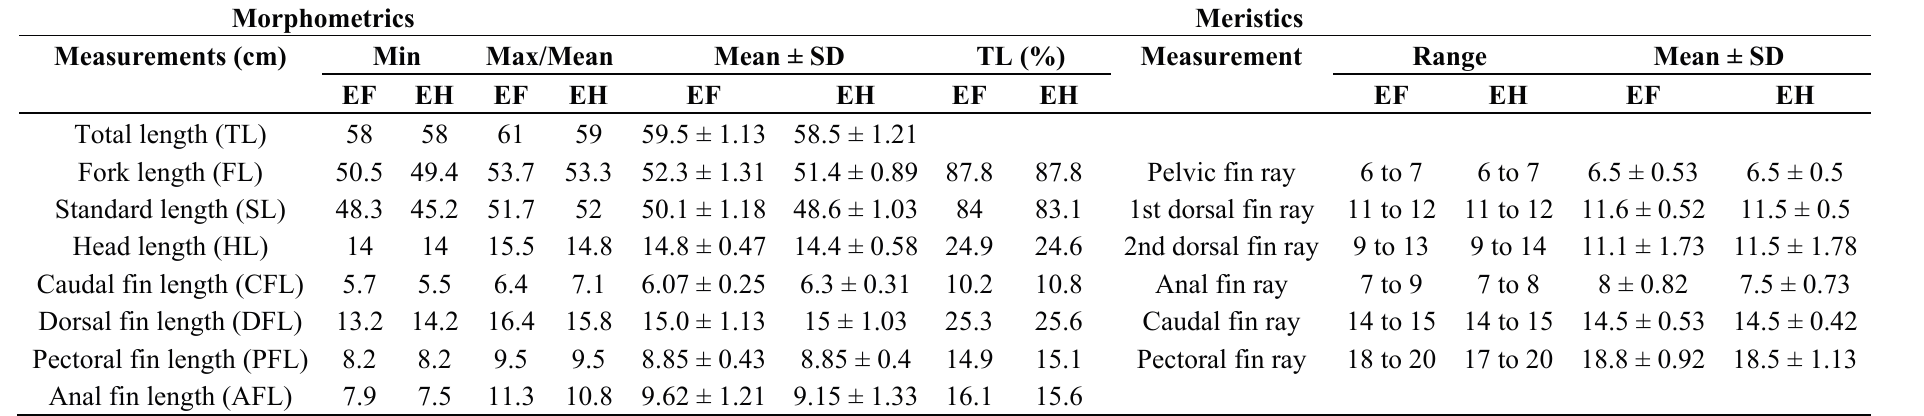
Table 2. Morphometric and meristic